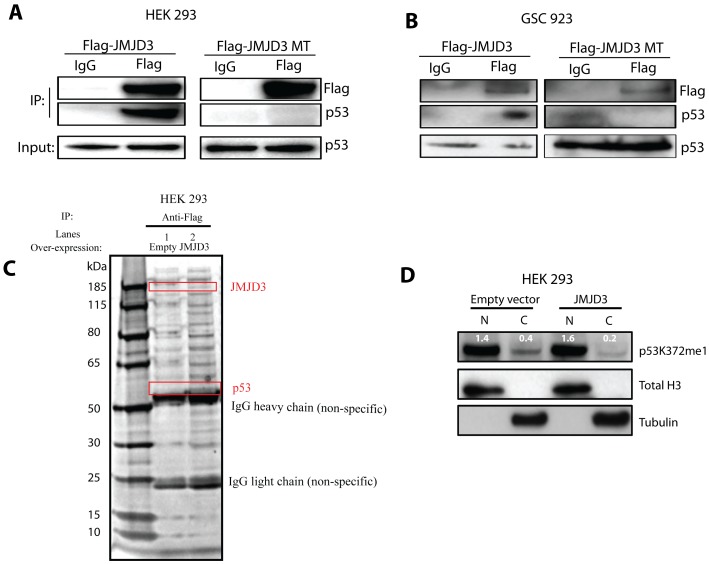
JMJD3 stabilizes p53 protein. A–B,Co-immunoprecipitation in HEK 293 cells (A) and GSC 923 (B) following overexpression of wild-type JMJD3 (in-tact catalytic domain) and mutant JMJD3 (MT; deleted catalytic domain) and western blot analysis for endogenous p53 protein. IP, immunoprecipitation. C, Mass spectrometry on JMJD3 interacting proteins in HEK 293 cells. D, Effect of JMJD3 overexpression on the cellular distribution of mono-methylated p53 lysine 372 (p53K372me1). N-Nuclear fraction and C-Cytoplasmic fraction. Total Histone 3 (Total H3) was used as nuclear fraction control and Tubulin as cytoplasmic fraction control. Densitometry values of p53K372me1 (white) are relative to respective nuclear or cytoplasmic control.